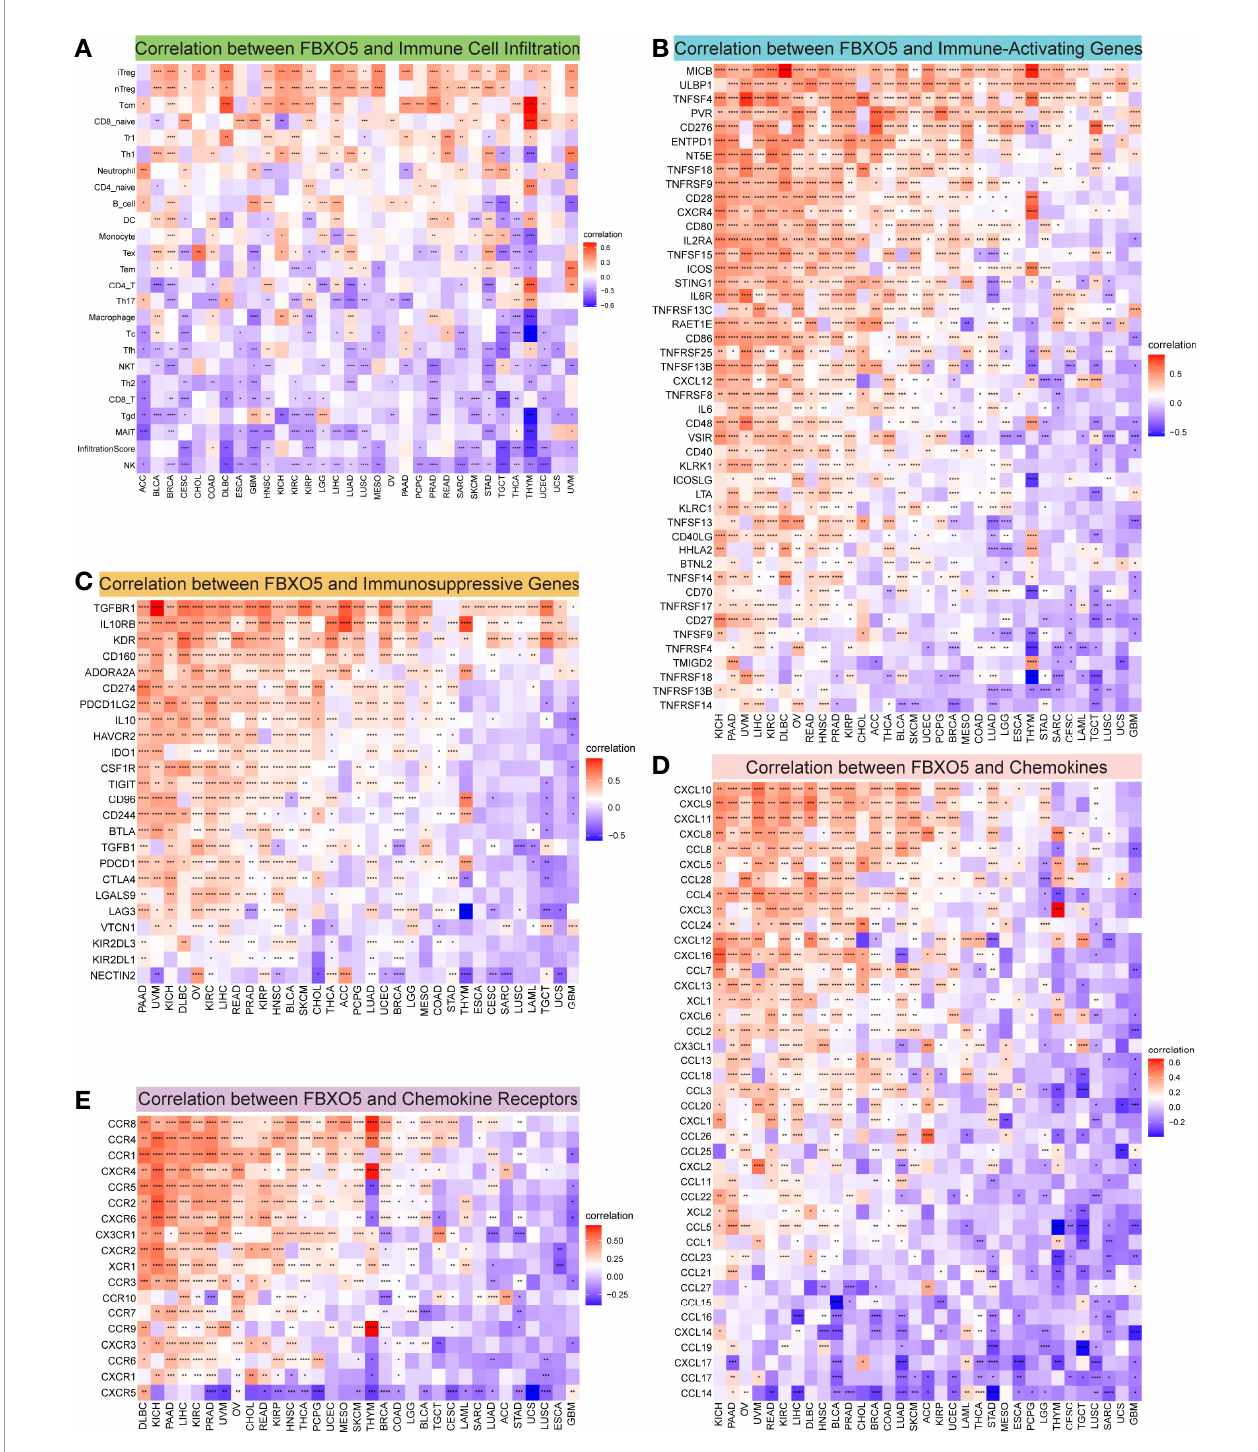
FIGURE 7 | Correlation between FBXO5 expression and tumor immunity. (A) Heatmap showing the association between FBXO5 expression and the in fi ltration of immune cells in pan-cancer generated by using the ImmuCellAI database. (B – E) Heatmaps indicating the co-expression of FBXO5 with immune-relevant genes in pan-cancer, including immune activation genes (B) , immunosuppressive genes (C) , chemokine genes (D) , and chemokine-receptor genes (E) . * p -value < 0.05, ** p - value < 0.01, *** p -value < 0.001, and **** p -value <